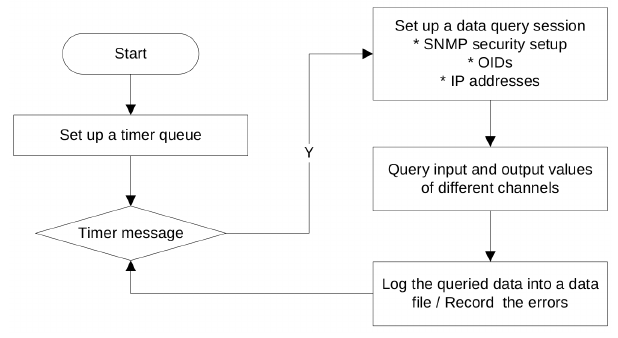
Fig. A2. Flowchart for data acquisition and Fig. 17. Flowchart for data acquisition and logging. Fig. 17. Flowchart for data acquisition and logging.